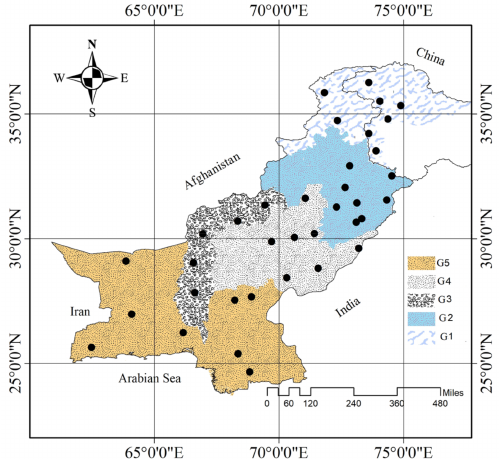
Figure 1. Spatial distribution of five different climatic region (G-1 to G-5) and Gauges in the selected area of